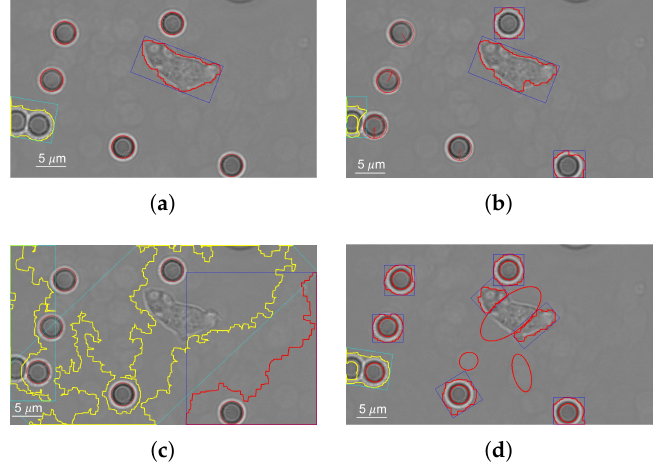
Figure 20. Processed images of amoeba cells and silica beads in water using various perception methods: ( a ) Maximally stable extremal regions (MSER) with circularity parameter; ( b ) Speeded up robust features (SURF); ( c ) Canny edge detector with Otsu’s thresholding; ( d ) MSER.